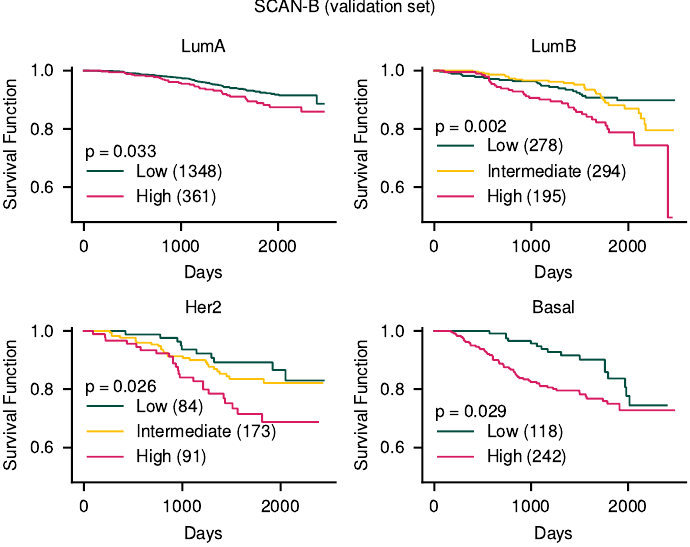
Figure 3. Kaplan–Meier curves for predicted risk groups within each subtype in SCAN-B data. Significant differences were observed among groups in the order of risk. In the TCGA-BRCA data set, the survival score was 2.00, and in the SCAN-B data set, the survival score was 1.22. The number in parentheses means the number of samples. p -values were results of multivariate log-rank tests. The results for TCGA-BRCA data are shown in Figure